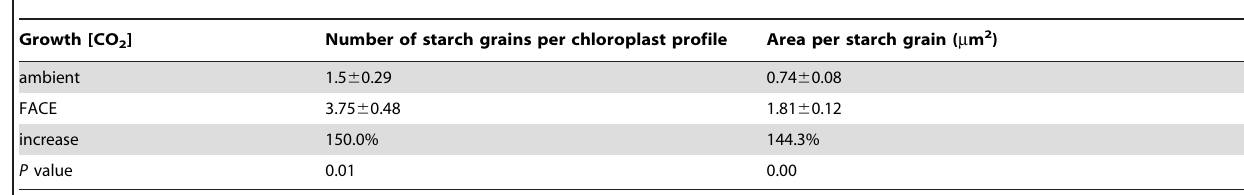
Table 3. Effects of elevated [CO 2 ] on chloroplast feature of I. indigotica.